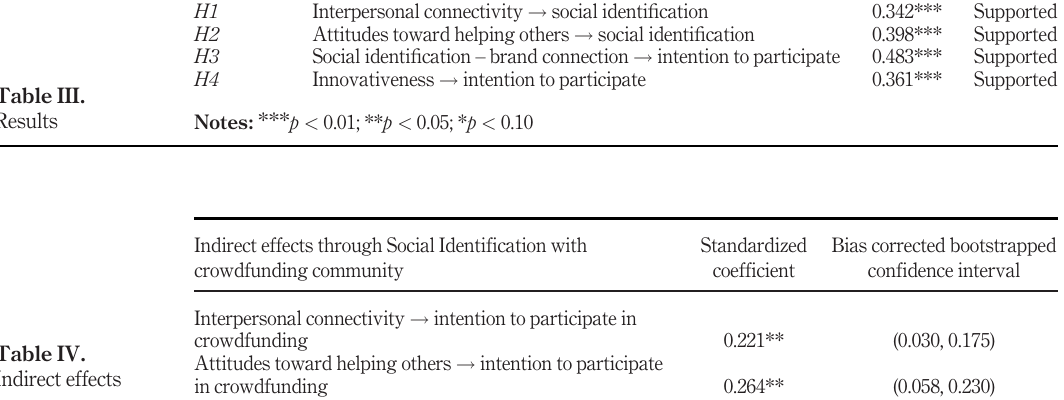
Table IV. Indirect effects